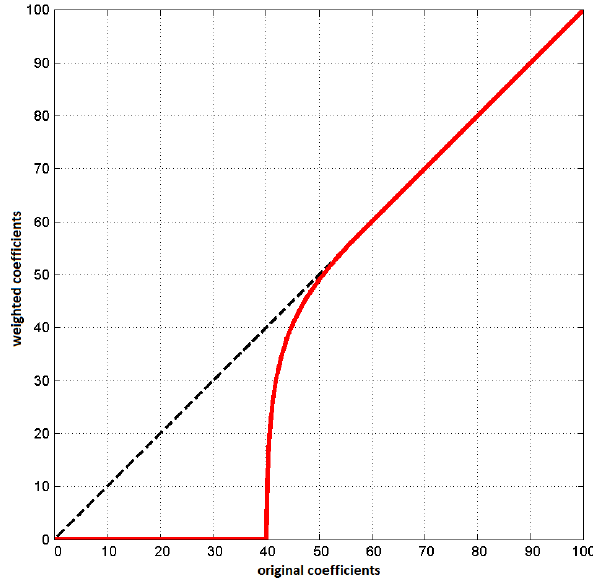
Figure 10. Weighted coefficients (red) for the borders a = 40 and b = 60 in relation to the